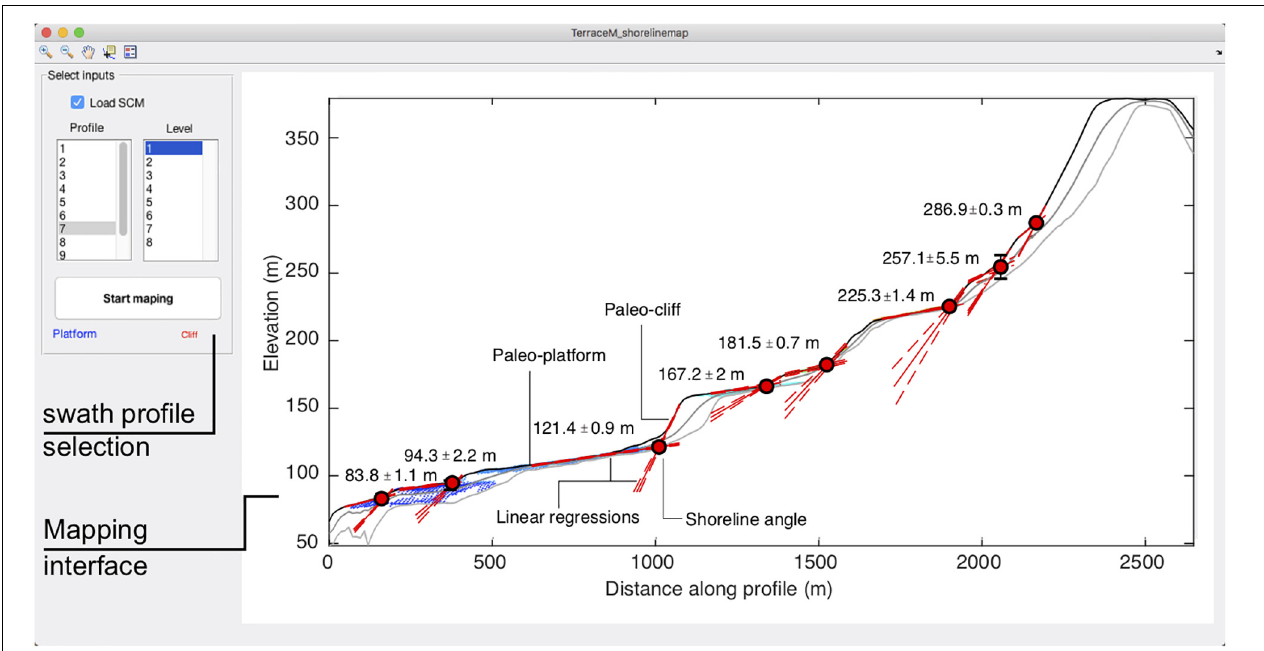
FIGURE 3 | Shoreline mapping GUI. Numbers indicate elevation and error of shoreline angle measurements. Left panels allow for interactive selection of swath profiles and mapping methods.